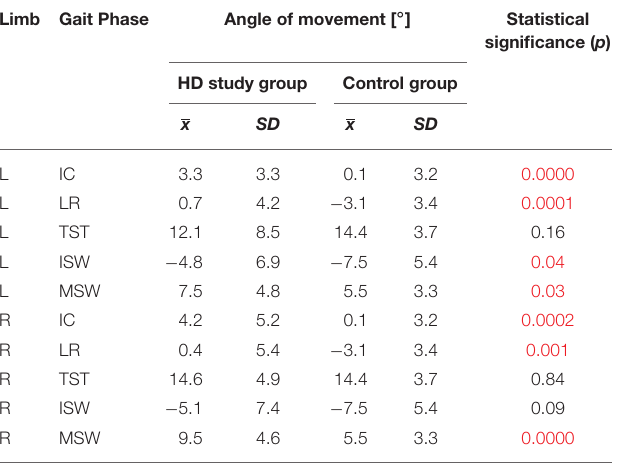
TABLE 6 | Angular changes in the trunk (spine bend, sagittal plane) compared with controls group. Limb Analyzed Angle of movement [ ◦ ] Statistical parameter significance ( p significance ( p )